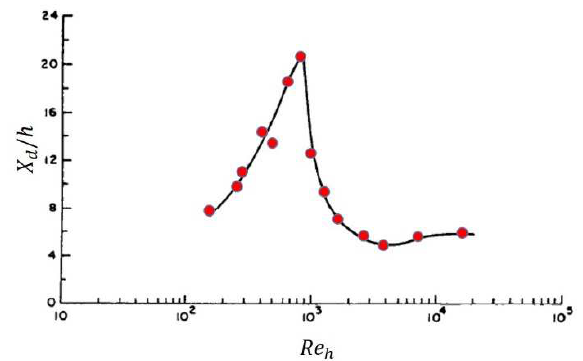
Fig. 3. Non-dimensional distance of reattachment versus Reynolds number (modified from Westphal et al, 1984 [19]).